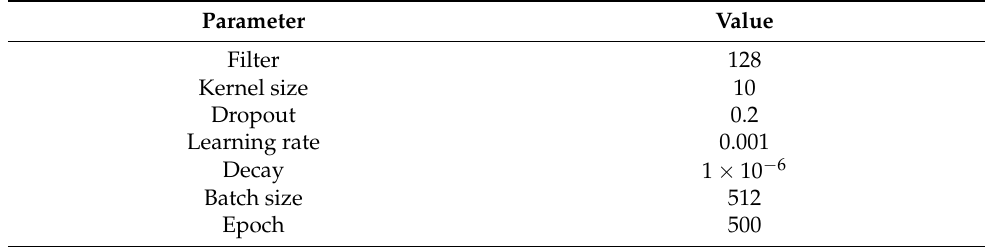
Table 2. Parameter tuning of the proposed